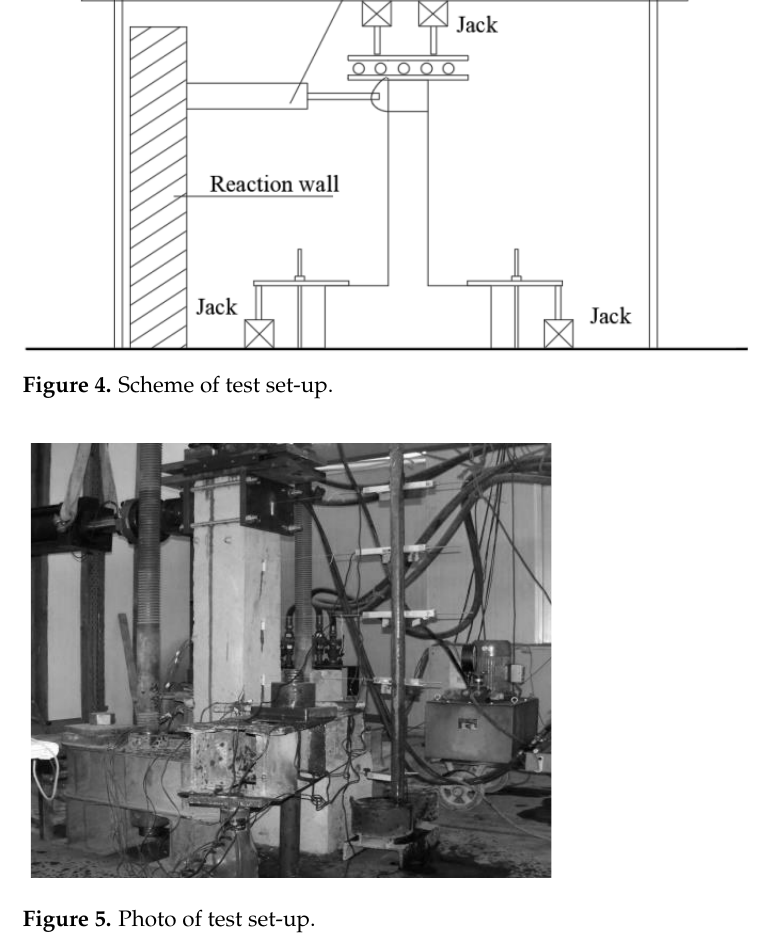
Figure 5. Photo of test set-up.